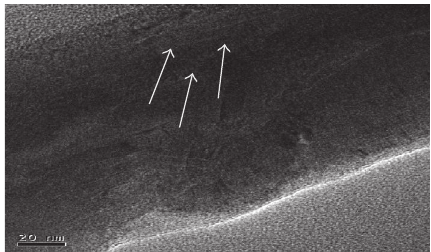
Figure 5: Transmission Electron Microscopy images of layered structure of CNF.